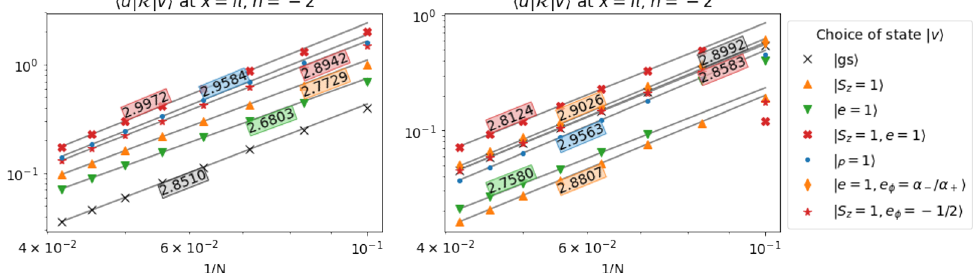
Figure 9 . Absolute value of matrix elements of R as de(cid:12)ned in (7.11), plotted using the same conventions as in (cid:12)gure 3 up to the choice of j u i : for each state j v i the state j u i corresponds to the same choice of lattice parameters up to a change in momentum sector, p ! p + 2. To the left, the lowest energy state for each choice of lattice parameters is used for j u i . To the right, the (cid:12)rst excited energy state is used for j u i instead.